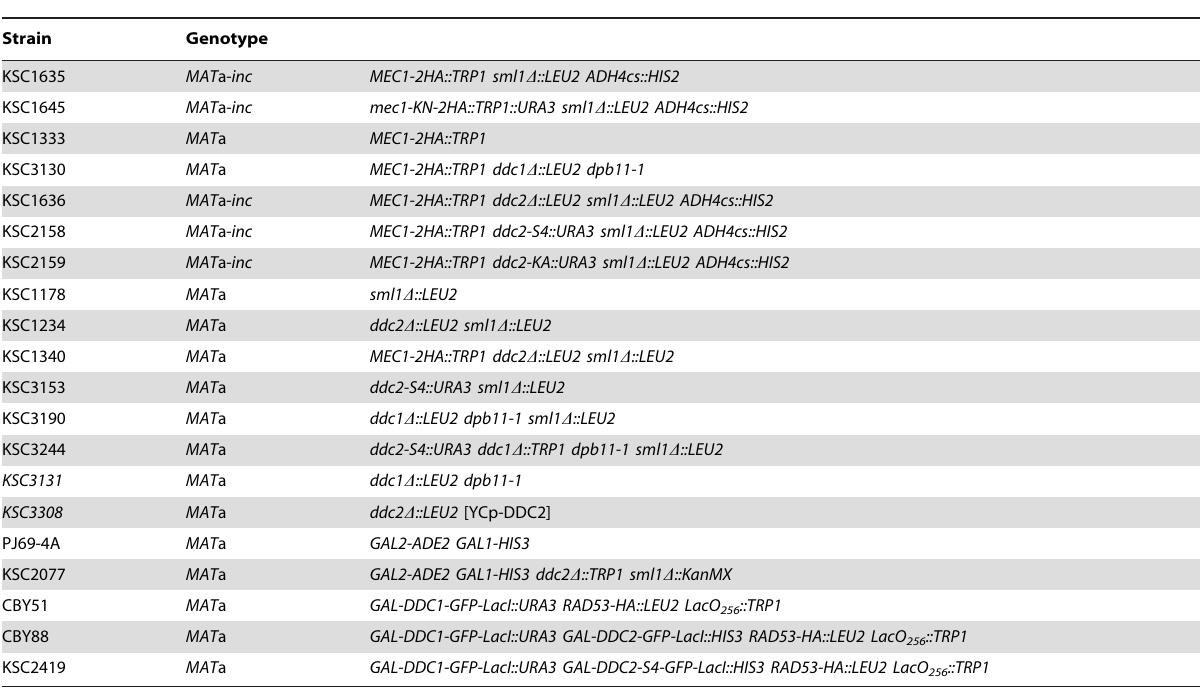
Table 1. Strains used in this